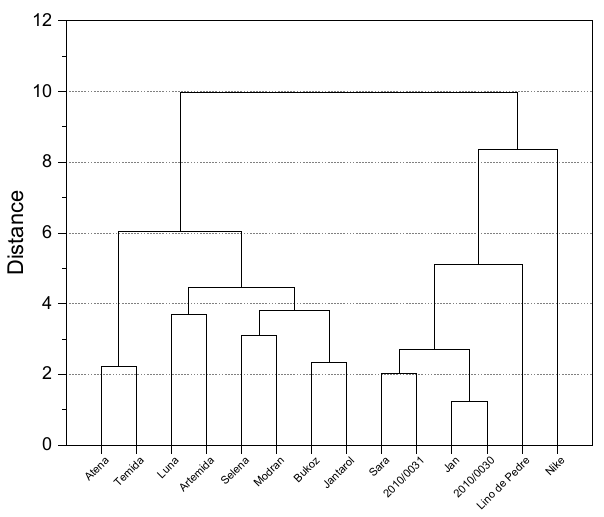
Fig. 7 Dendrogram derived from a cluster analysis of 14 flax accessions native to Poland and the Ukraine (Group I).